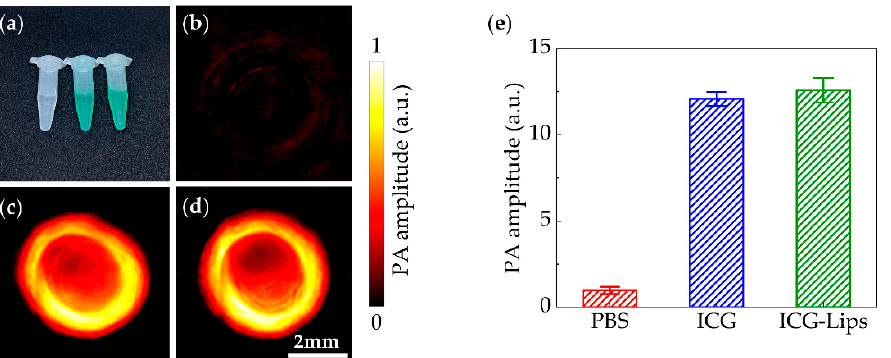
Figure 7. The comparison of PA performances. ( a ) The photograph of PBS, free ICG, and ICG-Lips (containing 50 µg/mL ICG) in centrifuge tubes; ( b – d ) PA images of PBS, free ICG, and ICG-Lips; ( e ) The PA amplitude of PBS, free ICG, and ICG-Lips in transparent plastic tubes with laser wave- length at 780 nm. PBS, phosphate-buffered saline. Error bars represent the standard deviations from 30 independent